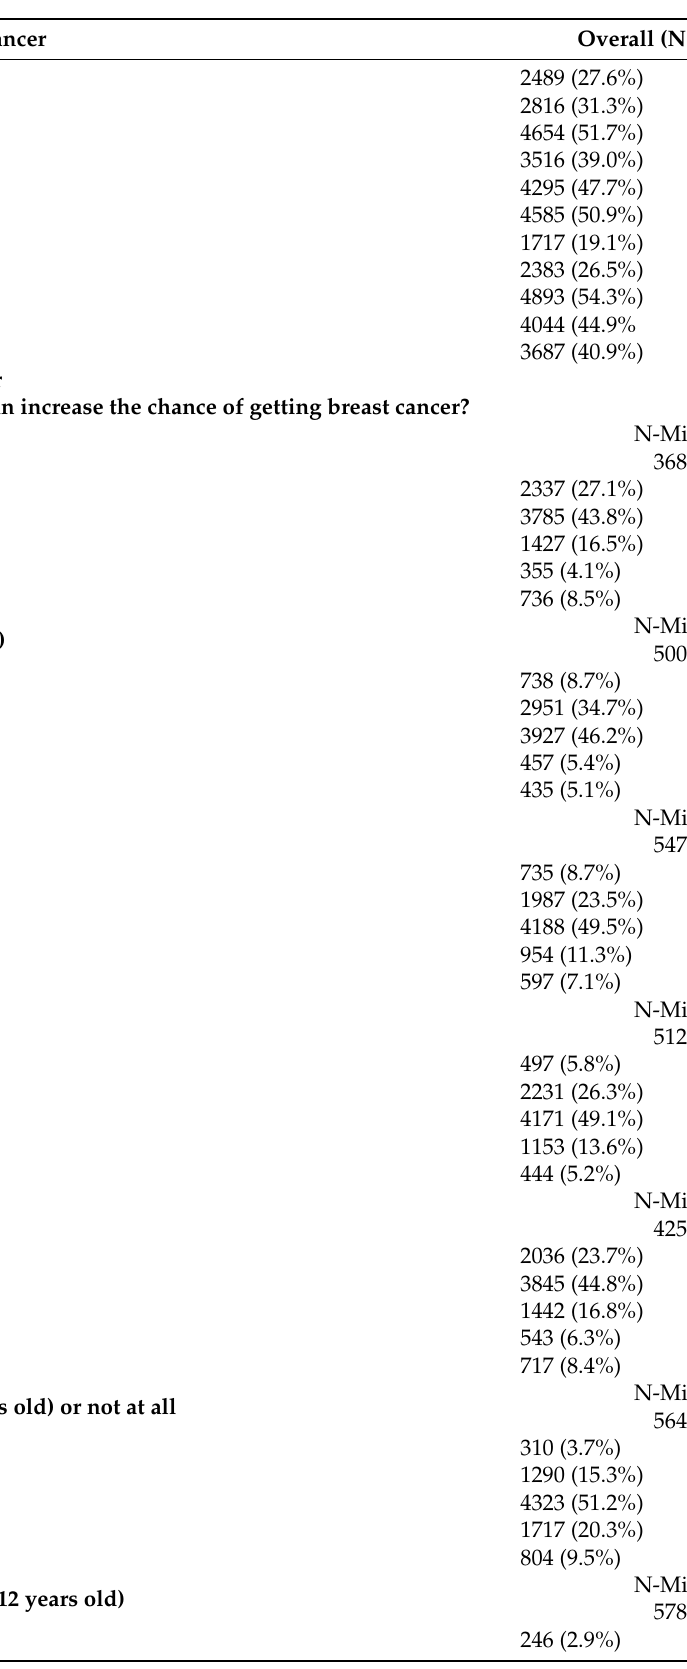
Table 2. Awareness of the warning signs and risk factors of breast